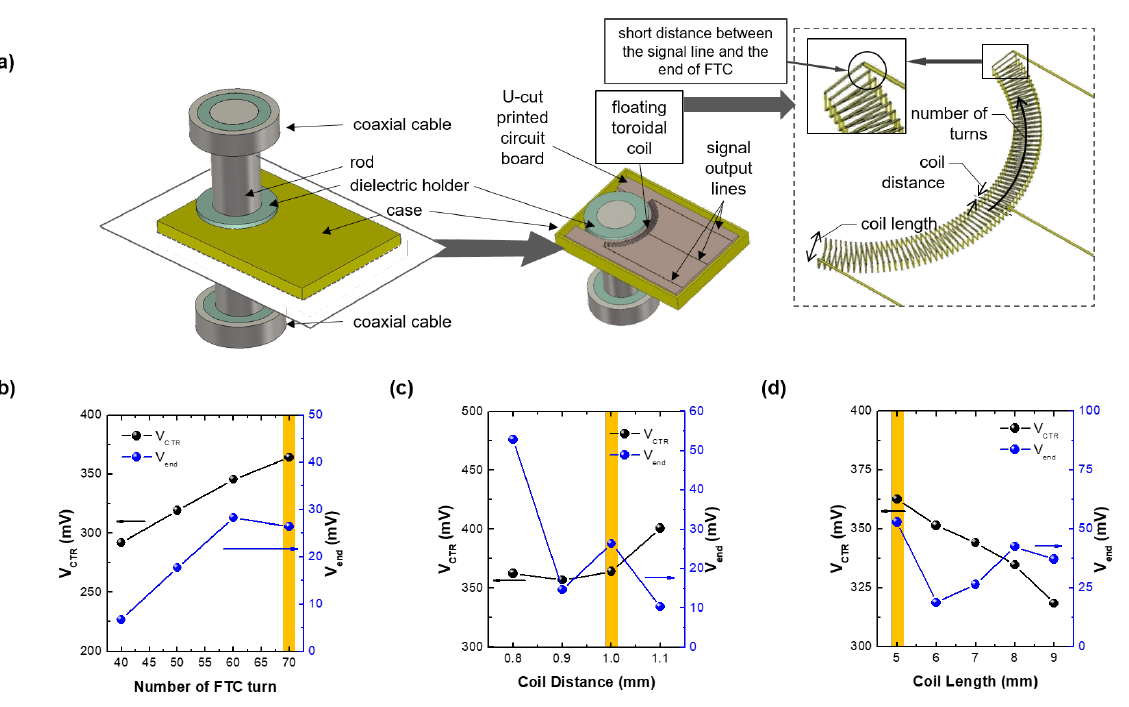
Figure 4. ( a ) Schematic of the VI probe showing the FTC embedded in the PCB, rod, and coaxial lines. The parameters for optimization are illustrated in the dashed box. Magnitude of the voltage difference between the ends of the FTC ( V end ) and between the center of the coil and ground ( V CTR ) by number of toroidal coil turns ( b ), coil distance ( c ), and coil length ( d ). The yellow bars highlight the optimum